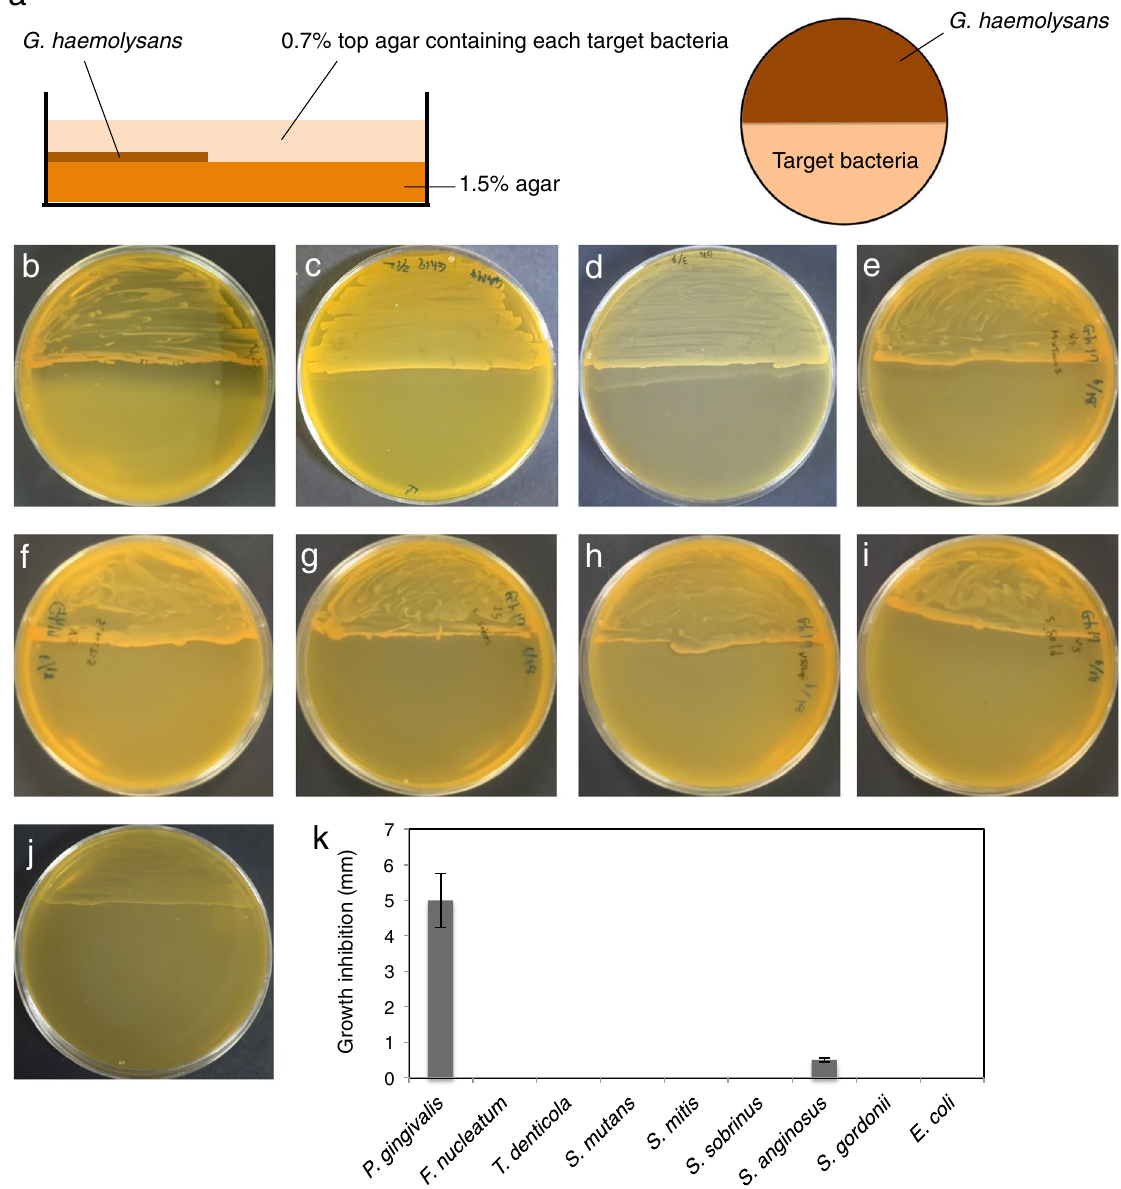
Figure 4. Target specificity of the growth inhibition activity of G. haemolysans . (a) Schematic depiction of the soft-agar overlay technique used to investigate the growth inhibition activity of G. haemolysans . (b–j) The soft 0.7% agar in the top layer was inoculated with the target bacterium i.e., P. gingivalis (b) , F. nucleatum (c) , T. denticola (d) , S. mutans (e) , S. mitis (f) , S. sobrinus (g) , S. anginosus (h) , S. gordonii (i) and E. coli (j) , while the 1.5% agar bottom layer was inoculated with G. haemolysans . (k) Quantification of the growth inhibition zone between G. haemolysans and each bacterium. Error bars show the mean ± SD. All results are representative of data generated in at least two independent